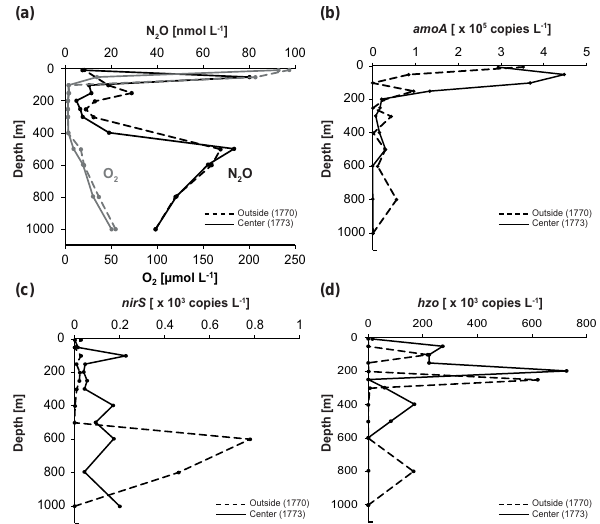
Figure 5. Vertical distribution of N 2 O and O 2 concentrations (a) , as well as gene abundance of amoA (b) , nirS (c) , and hzo (d) within the centre (solid lines) and outside (dashed lines) of eddy A in De- cember 2012 (M91 cruise). The numbers in parentheses indicate the station numbers (cf. Fig.